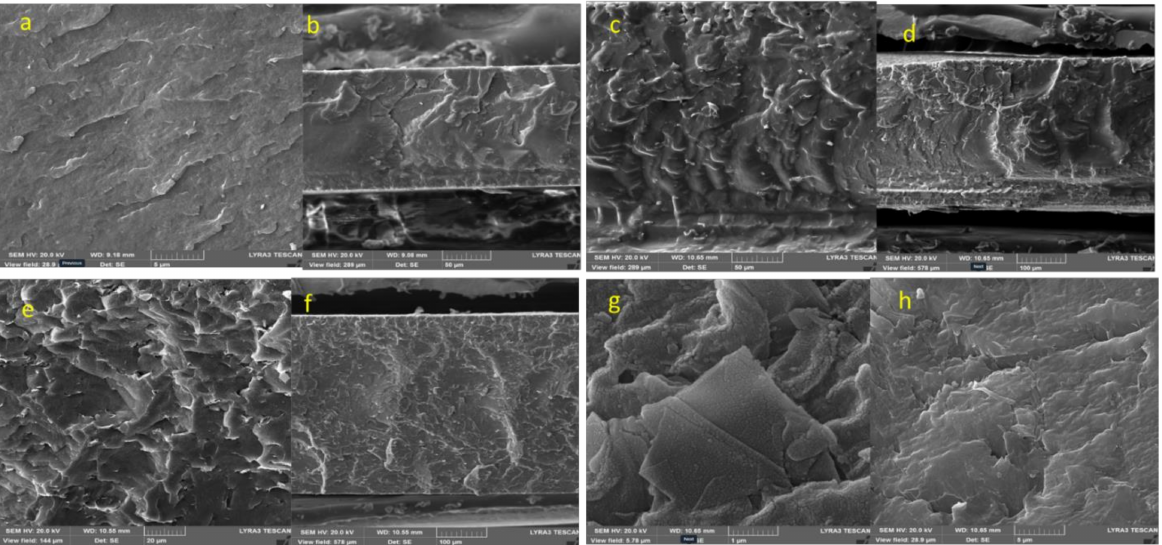
Figure 12. ( a ) PVDF virgin (MDFG0) (top surface), ( b ) MDFG0 fracture surface, ( c ) MDFG 0.5 (top surface), ( d ) MDFG 0.5 fracture surface, ( e ) MDFG 2.0 (top surface), ( f ) MDFG 2.0 fracture surface, ( g ) MDFG 5.0 (top surface), and ( h ) MDFG 5.0 fracture